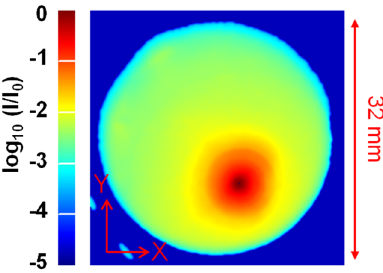
FIG. 16. Reconstructed image showing colorized logarithmic intensity contours of the beam, phosphor screen periphery, and